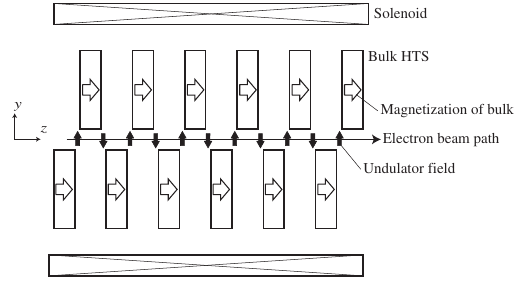
FIG. 1. Principle of the HTS-bulk staggered-array undulator, HSAU (side view). The solenoid coil induces the magnetization of the HTS bulks which then generate the y -direction